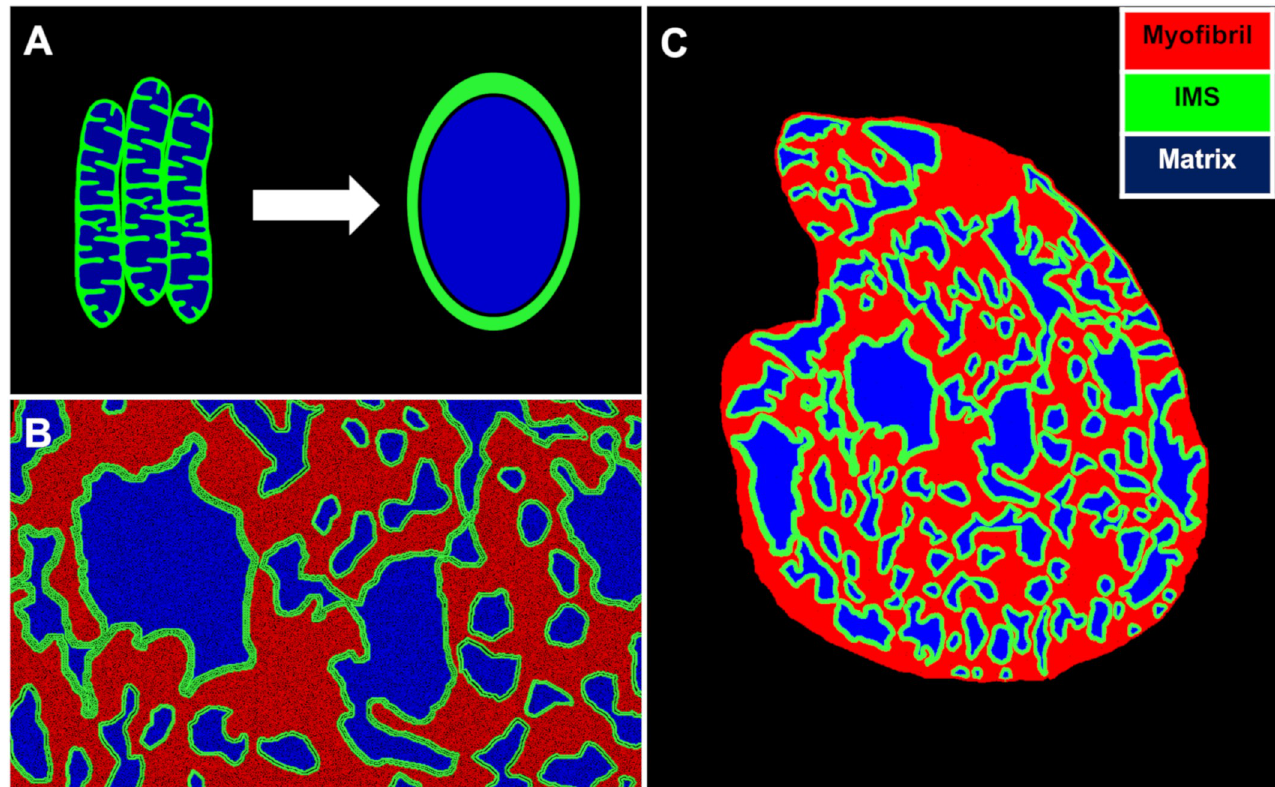
Fig 3. Model assumptions and FE mesh generation from EM image cross-sections. (A): We assumed that individual mitochondria that cluster together will share a common inner membrane space. (B): Based on this assumption, each mitochondrial cluster was divided into two regions: an IMS region, depicted in green and a matrix region, depicted in blue. A third region depicted in red covers the myofibrils present in the cell. (C): Image of a FE mesh developed from the EM image of cross-section 1 with the three different regions.